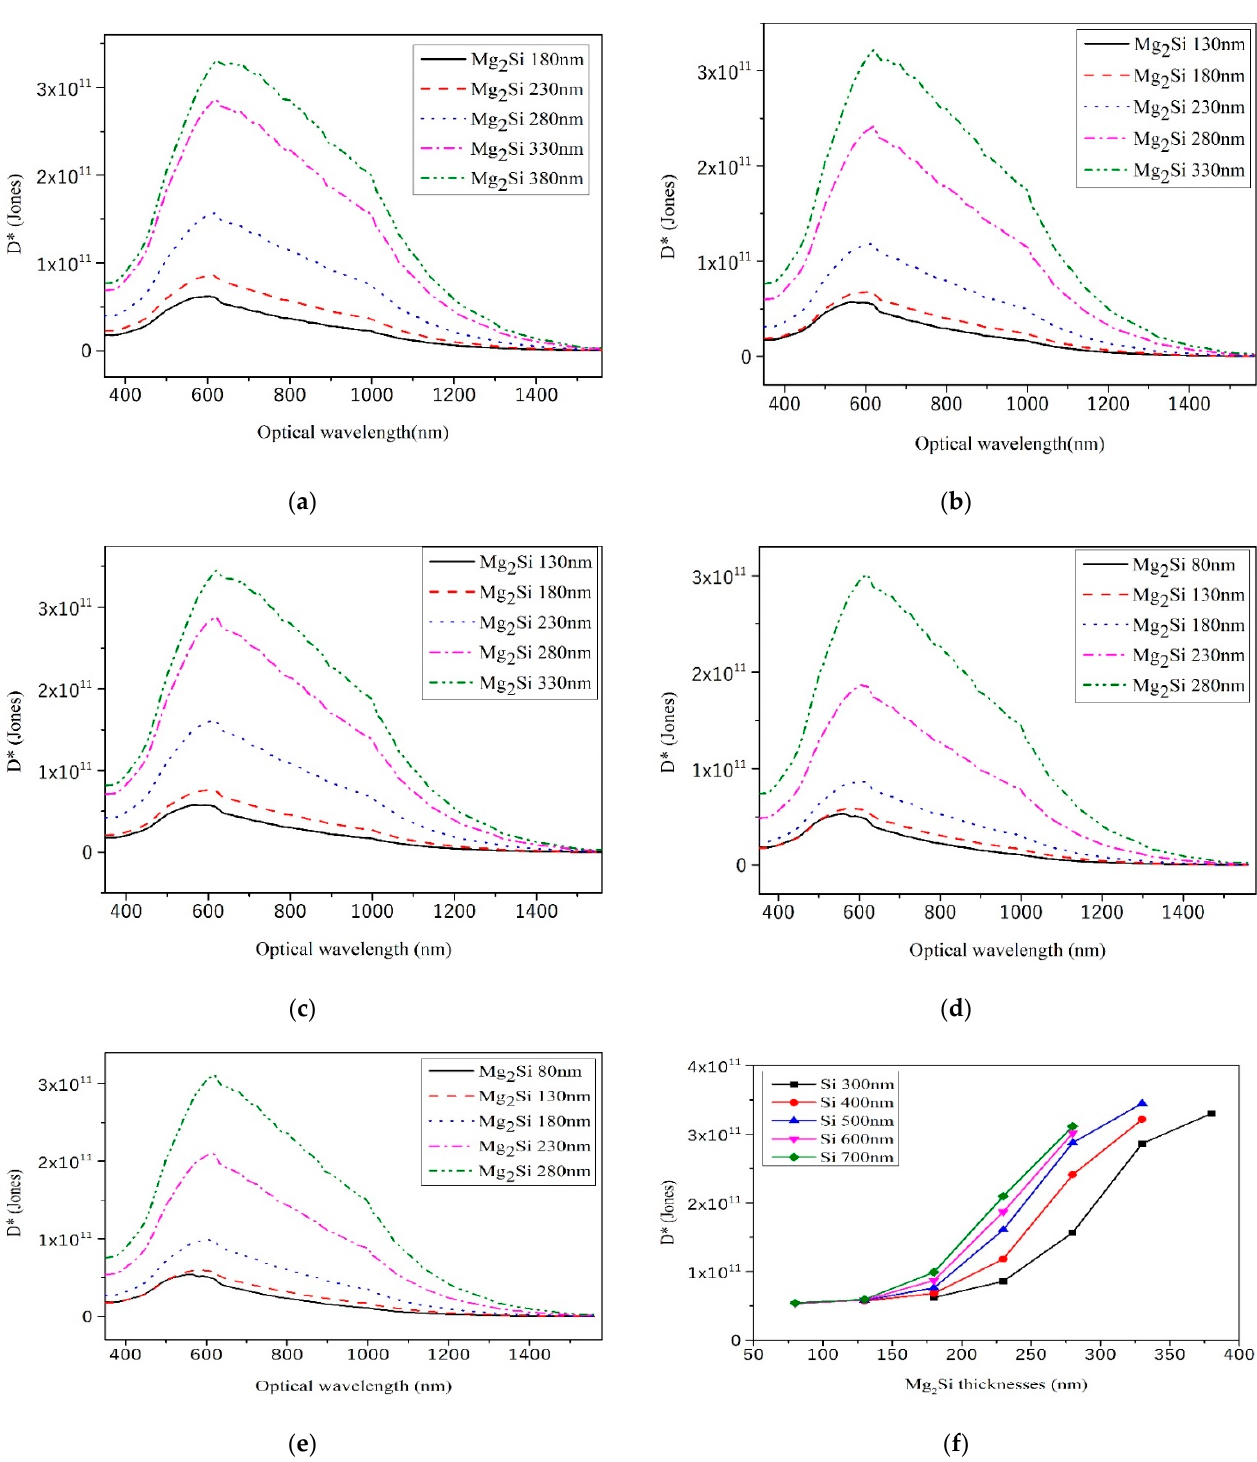
Figure 10. The D* curves of heterojunction PD with different Mg 2 Si thicknesses under the condition of 300 nm, 400 nm, 500 nm, 600 nm, and 700 nm thicknesses of Si. ( a ) Si-300 nm; ( b ) Si-400 nm; ( c ) Si-500 nm; ( d ) Si-600 nm; ( e ) Si-700 nm; ( f ) The effect of thicknesses on the D*